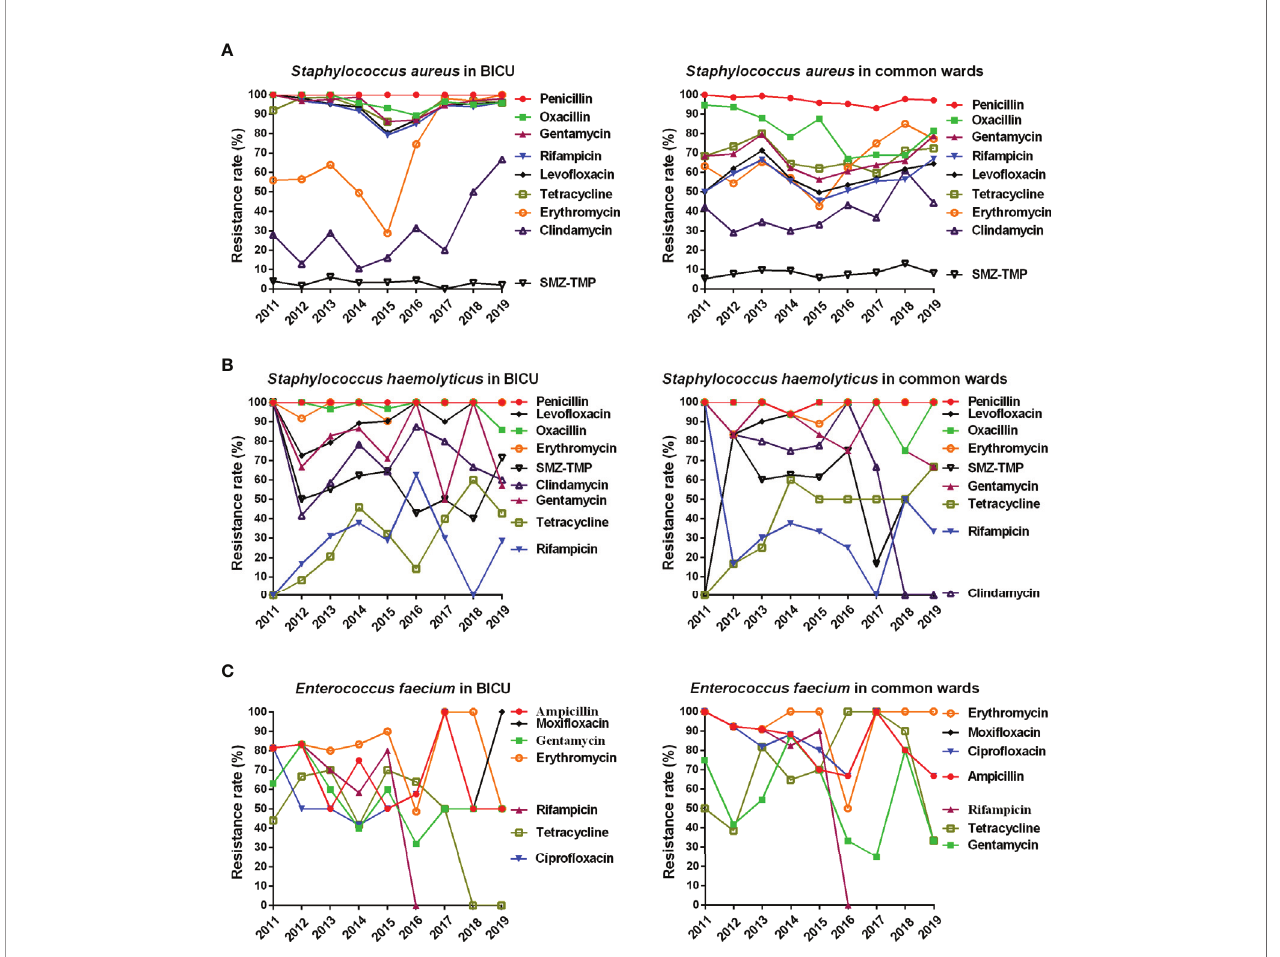
FIGURE 6 | Annual changes of antibacterial resistance of main Gram-positive bacteria. (A) Annual distribution of antibacterial resistance of Staphylococcus aureus from burn ICU (left) and common ward (right). (B) Annual distribution of antibacterial resistance of Staphylococcus haemolyticus from burn ICU (left) and common ward (right). (C) Annual distribution of antibacterial resistance of Enterococcus faecium from burn ICU (left) and common ward (right).